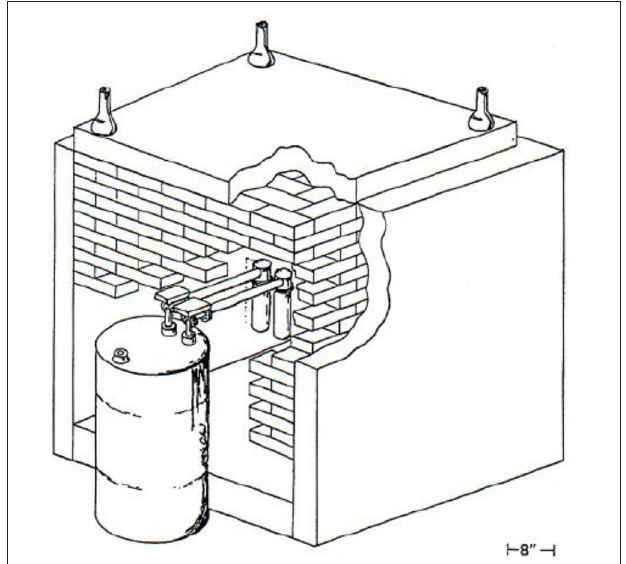
FIGURE 4 | A diagram of the first IGEX-II detectors in the Homestake gold mine showing the detectors hanging vertically.